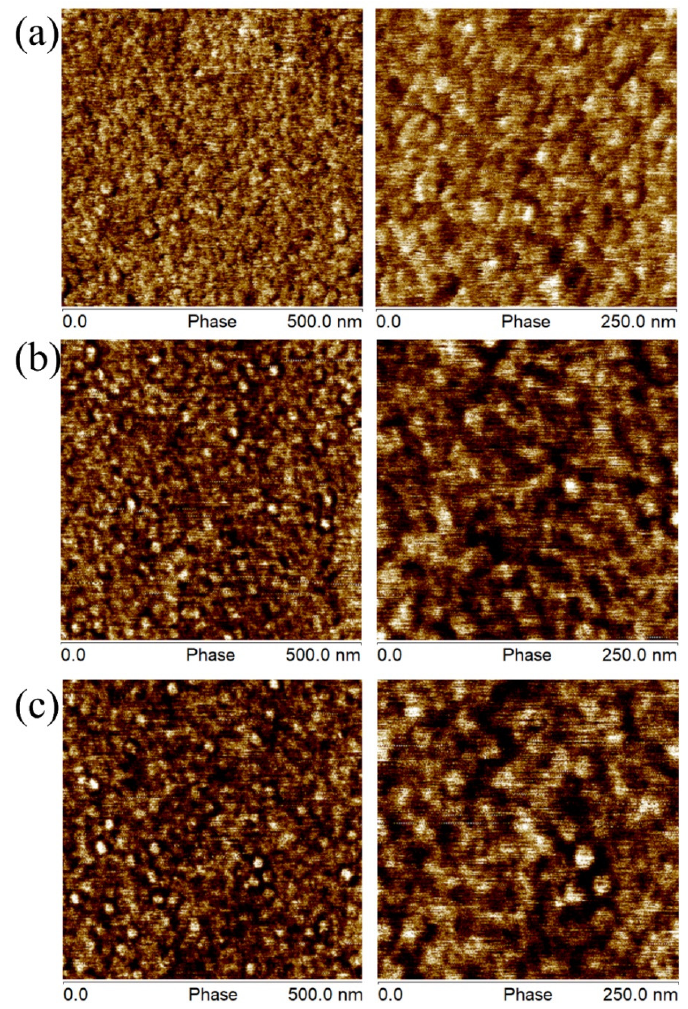
Figure 3. Atomic force microscopy (AFM) images (recorded on the thin film prepared through spin-coating) of ( a ) NVF-St-37.4 (No.2), ( b ) NVF-St-51.7 (No.4), and ( c ) NVF-St-58 (No.6).